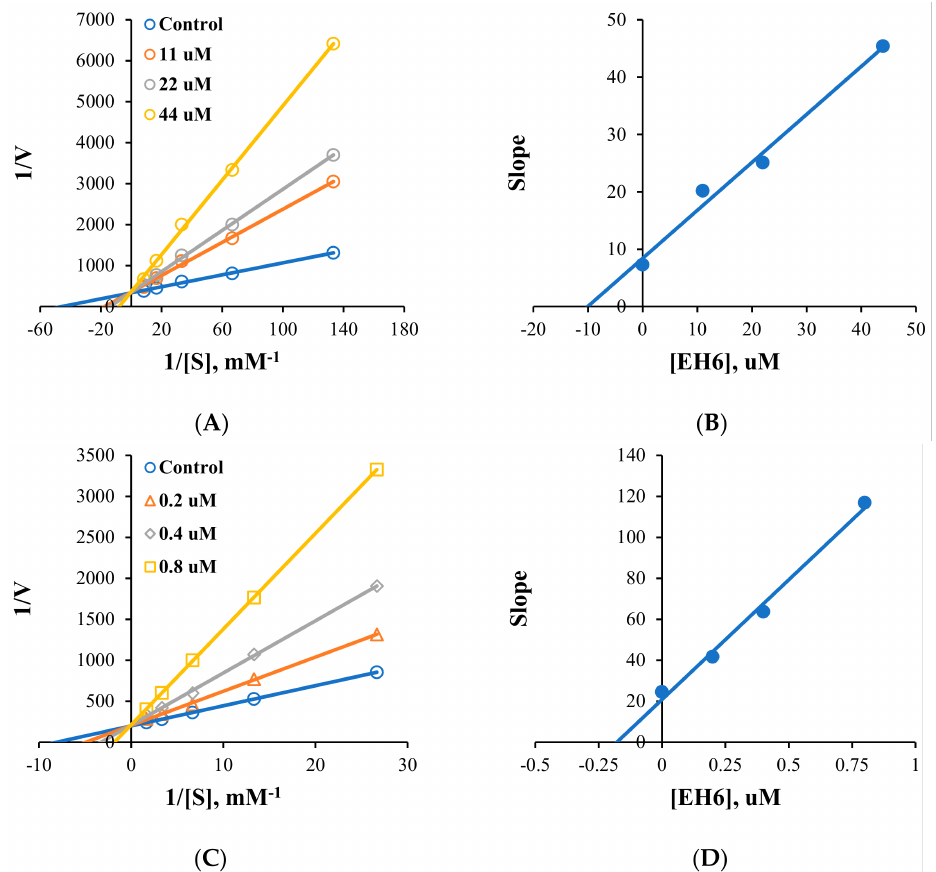
Figure 2. Lineweaver–Burk plots for MAO-A and MAO-B inhibitions by EH6 ( A , C ) and their respective secondary plots ( B , D ) of slopes vs. inhibitor